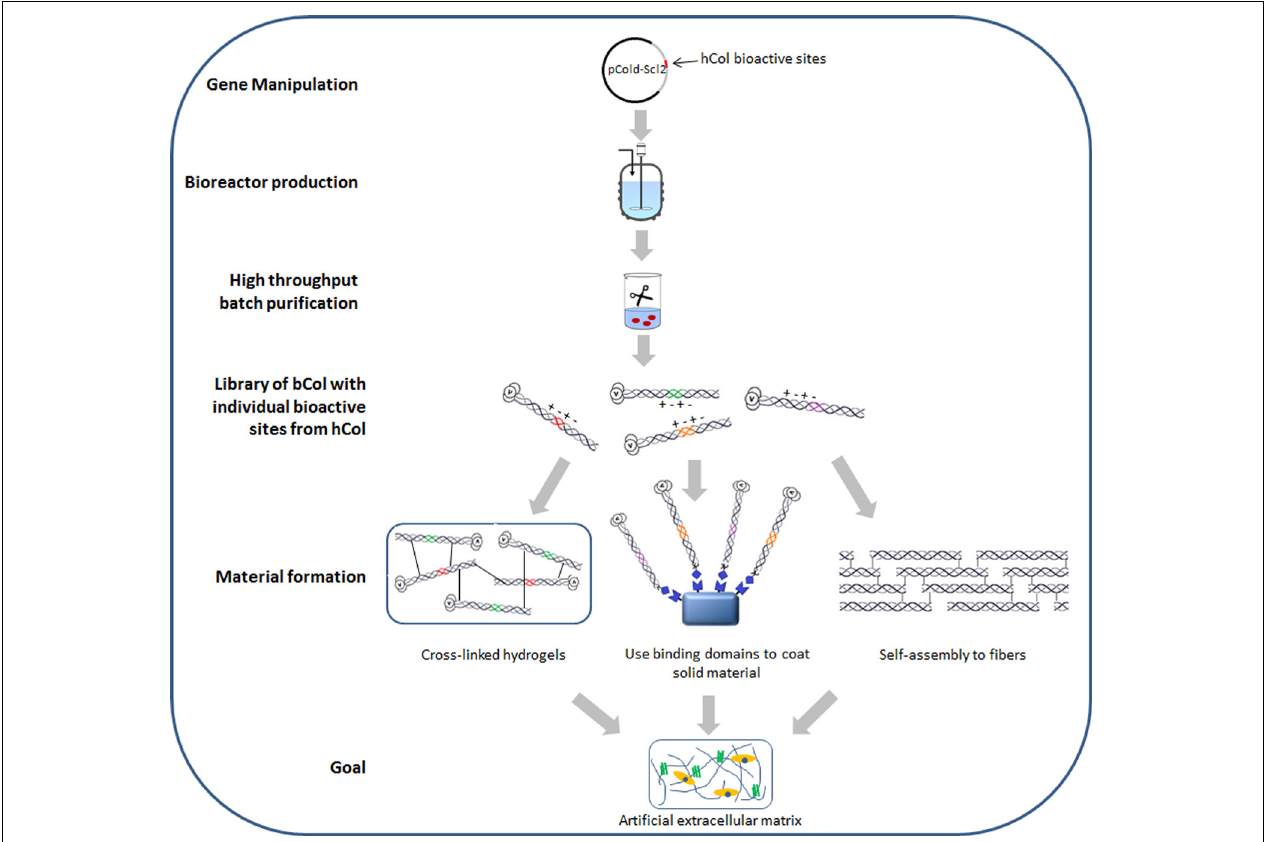
FIGURE 1 | Schematic diagram of recombinant bacterial collagen production method and material fabrication strategies. hCol, human collagen; bCol, recombinant bacterial collagen